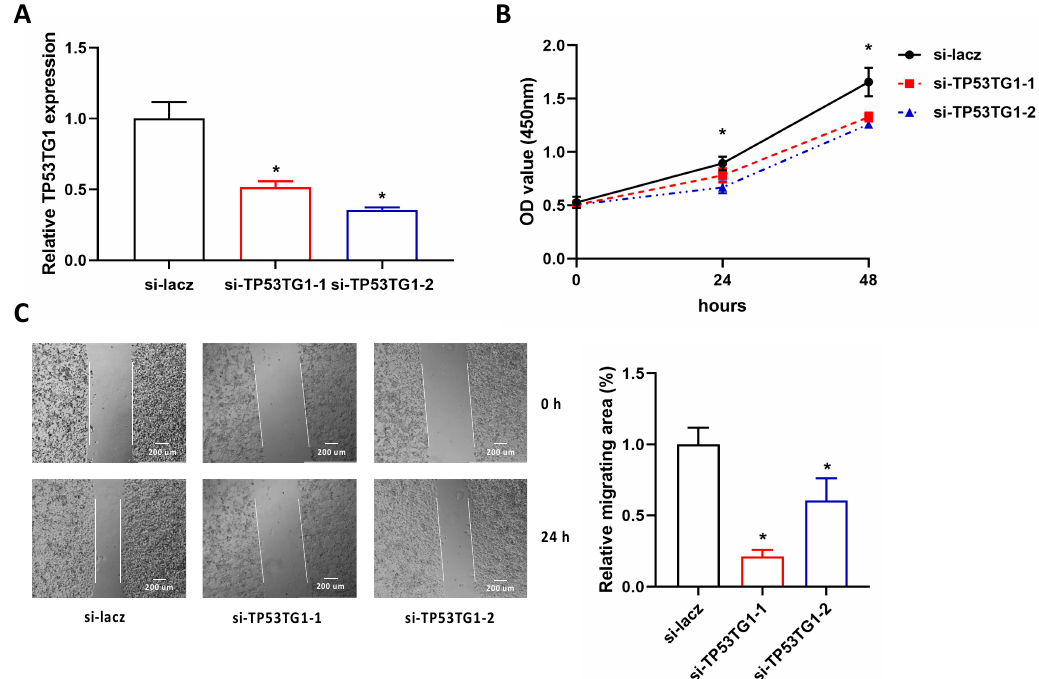
Figure 3. Knockdown of TP53TG1 suppresses cell proliferation and migration in PLC/PRF/5. ( A – C ) The RNA expression level of TP53TG1 (normalized to 18S), n = 3 ( A ), proliferation rate, error bars represent SD, n = 6 ( B ) and migration rate, n = 3 ( C ) in PLC/PRF/5 cells transfected with lacz siRNA or TP53TG1 siRNAs. * p < 0.05 (si-RNA vs.